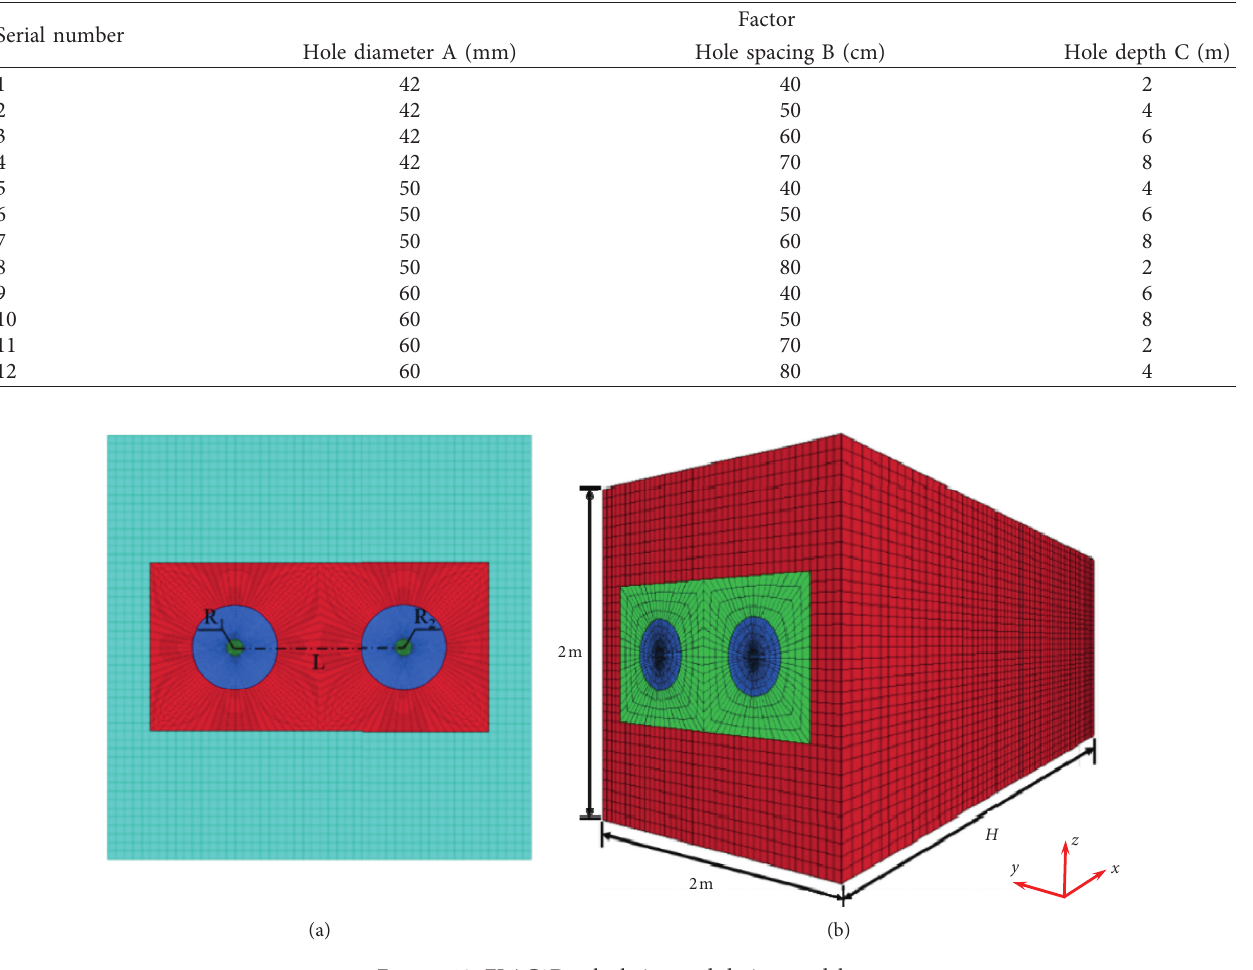
Figure 9: Relationship of hole diameter and swelling force. Table 4: Orthogonal test program.